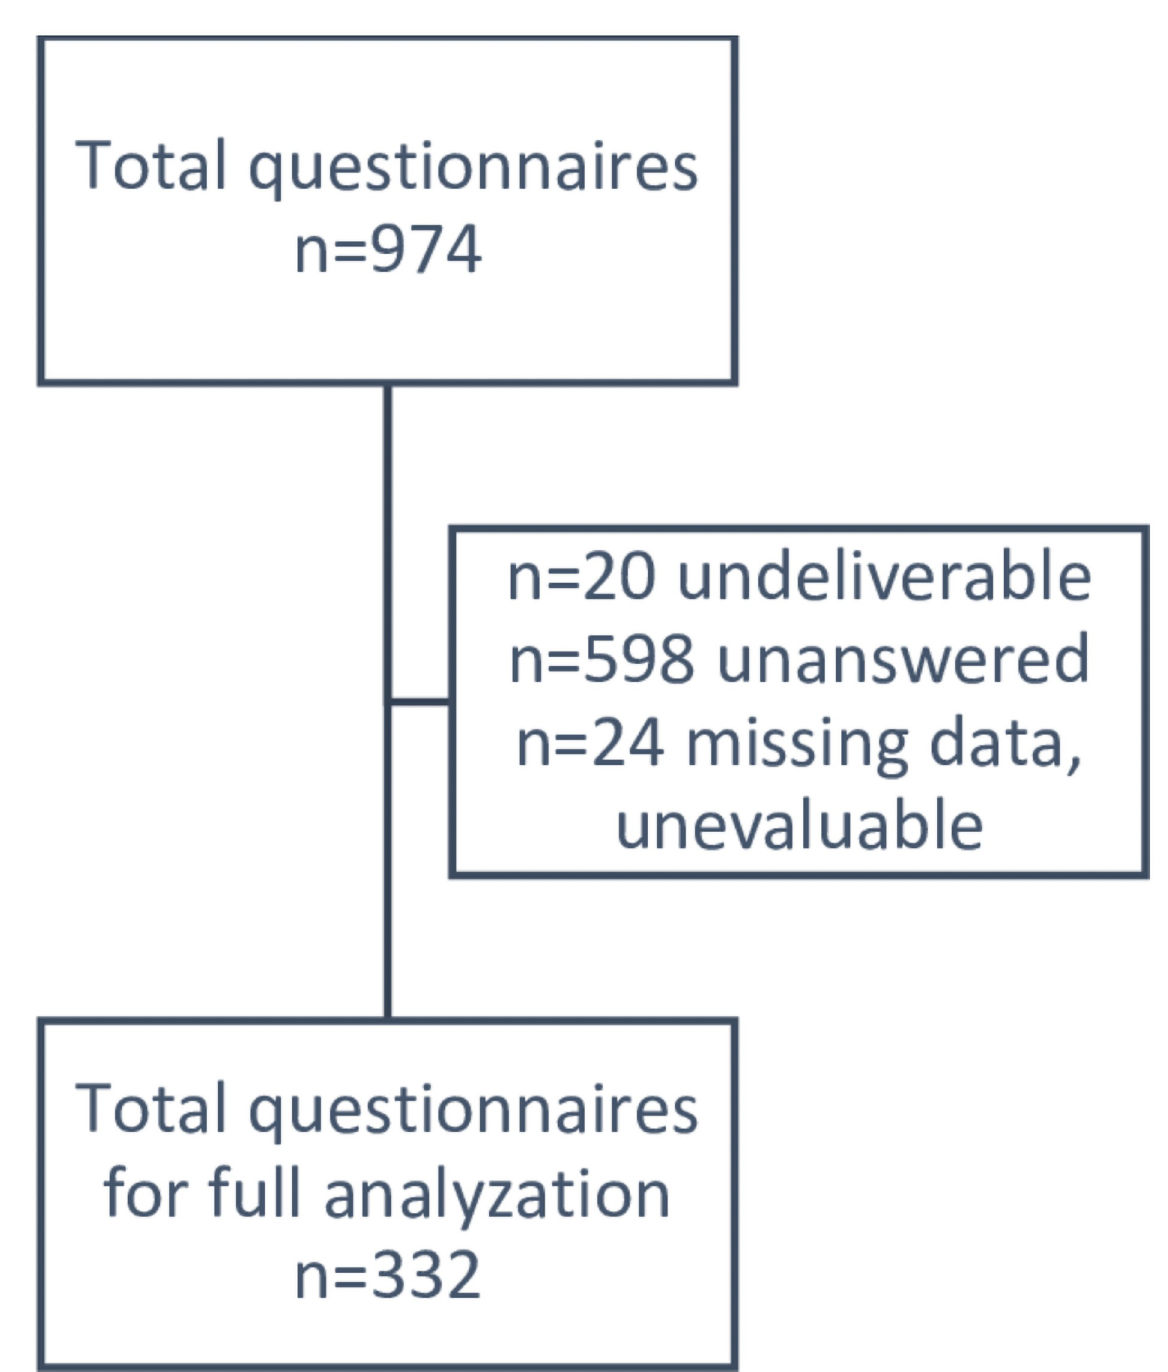
Fig 1. Strobe diagram on total, respectively analyzable questionnaires. Demographically, the majority of the participants were male (58%) between 71–80 years of age (42%) and moderately affected (48%) on a self-reporting basis, with the majority having been diagnosed for more than 10 years (48%). The more detailed demographic survey is pre- sented in Table 2.